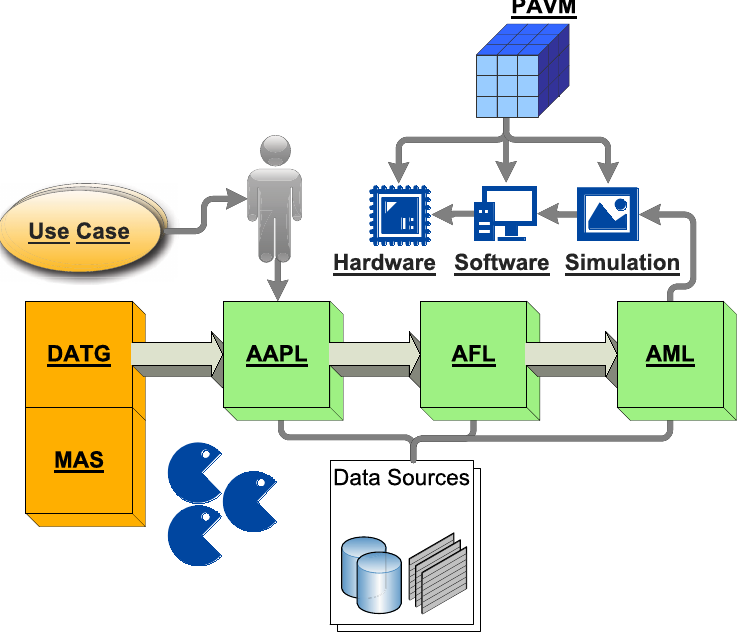
Design overview and design flow: from the model, to the programming, to the machine level, with one unique agent model (DATG, dynamic activity-transition graph; AAPL, Agent-orientated Programming Language; AFL, Agent ForthProgramming Language; AML, Agent Forth Machine Language; MAS, multi-agent system; PAVM, pipelined agent virtual